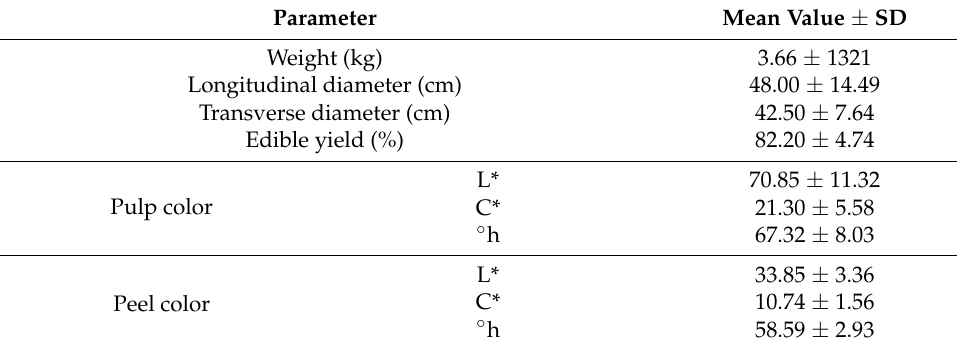
Table 1. Physical characterization of Ceiba aesculifolia subsp. parvifolia